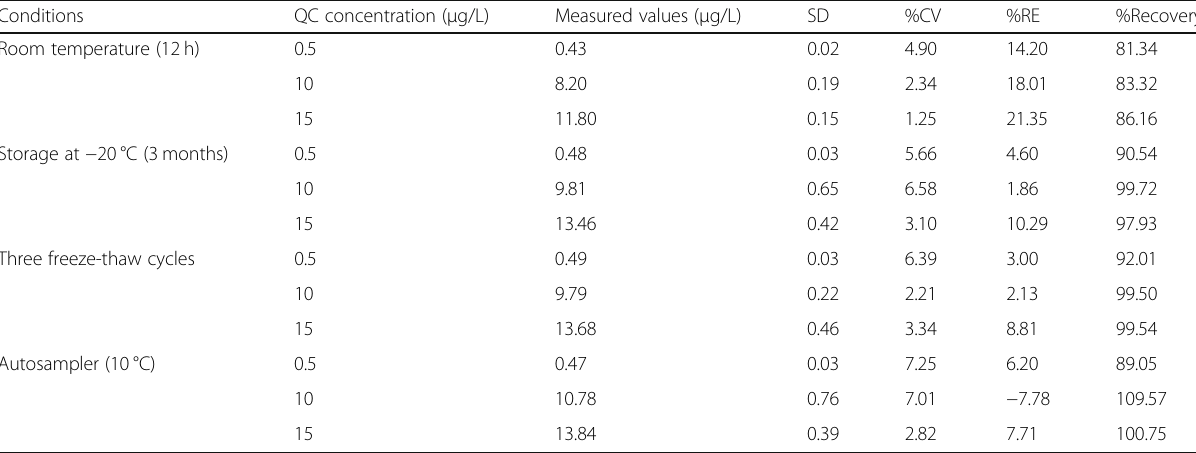
Table 4 The stability of cucurbitacin B at different storage conditions